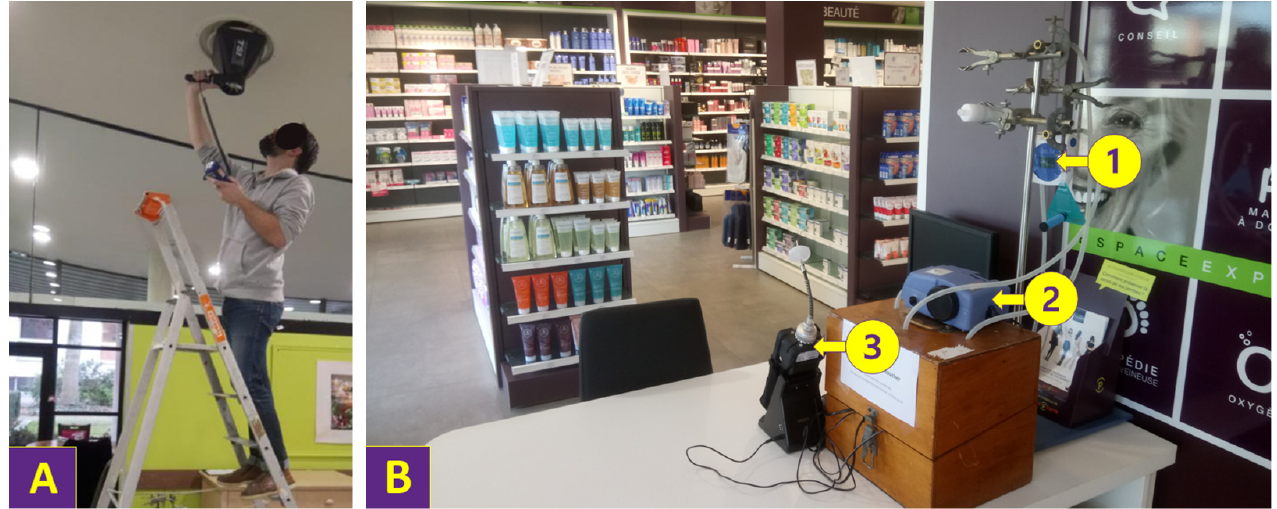
Figure 1. Examples of the flow rate measurements of an air vent in the refectory of an elderly care facility ( A ), and of the CO 2 (1), PM 2.5 (2) and TVOC (3) measurements in the commercial space of a pharmacy ( B ).